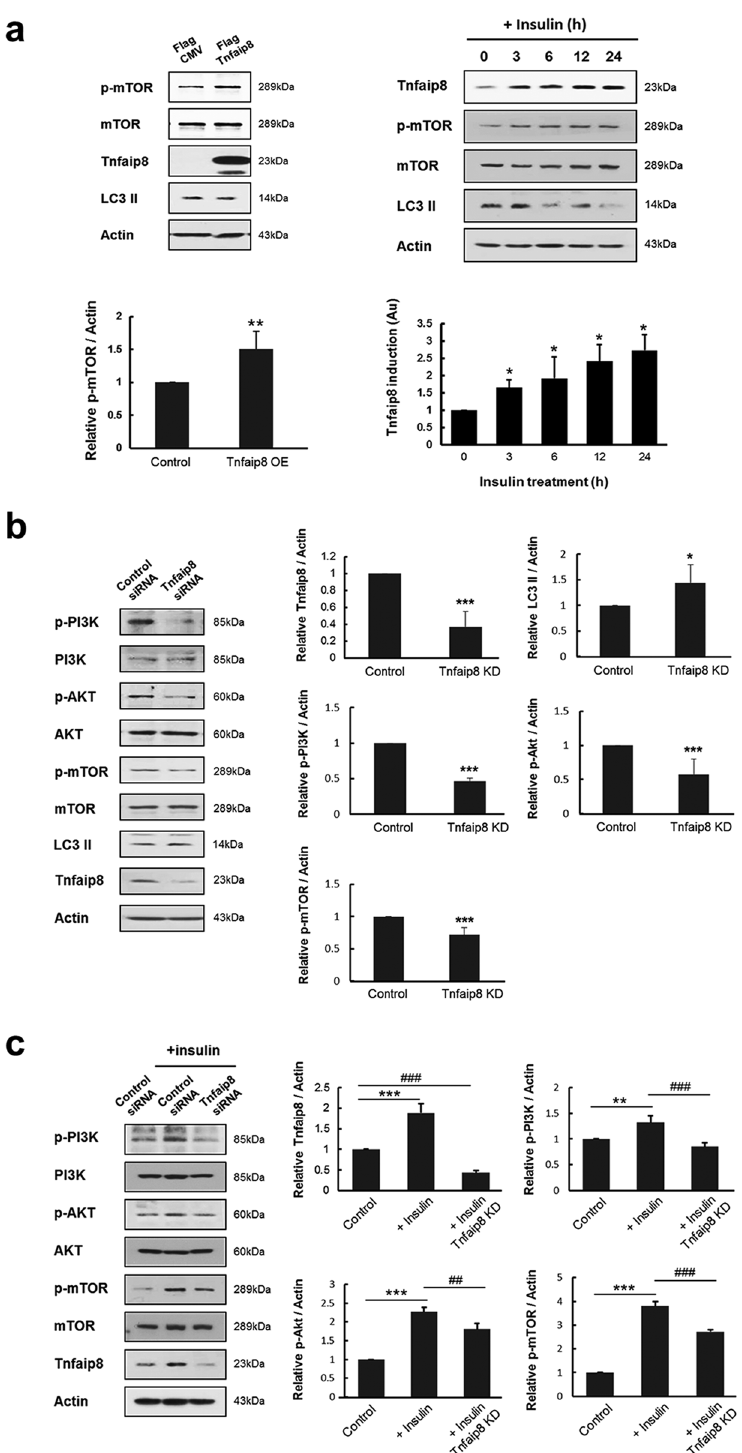
Figure 1. Temporal induction of mTnfaip8 by insulin. ( a ) mTnfaip8 was overexpressed in mouse hepatoma cells (Hepa 1 − 6) and phospho-mTOR and LC3 II levels were analyzed by immunoblotting after 48 h. The anti- autophagic activity of mTnfaip8 was confirmed (left panel). Hepa 1-6 cells were treated with insulin (1 µ g/ml), and the levels of mTnfaip8 were analyzed by immunoblotting at 0 - 24 h. Insulin induced significant increases in mTnfaip8 levels over 24 h, which was accompanied by a significant decrease in the autophagy marker LC3 II (i.e., inhibition of autophagy) (right panel). ( b , c ) mTnfaip8 gene KD was performed in either absence or presence of insulin (1 µ g/ml). The levels of phospho-PI3K, phospho-Akt and phospho-mTOR were analyzed by immunoblotting after 48 h. The levels of phospho-PI3K, phospho-Akt and phospho-mTOR were decreased significantly and autophagy was induced. Values are means (SD). * p < 0.05, ## p/ ** p < 0.01, ### p/ *** p < 0.001. The full-length blots are presented in Supplementary Figure 2 (Fig.